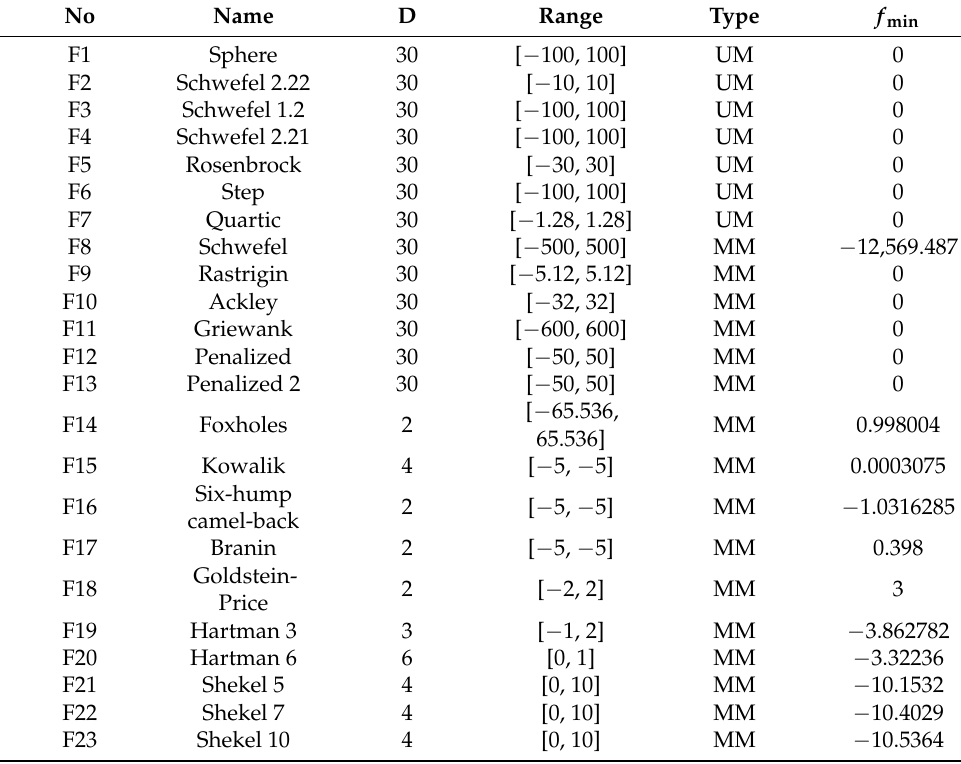
Table 1. Definition of 23 benchmark